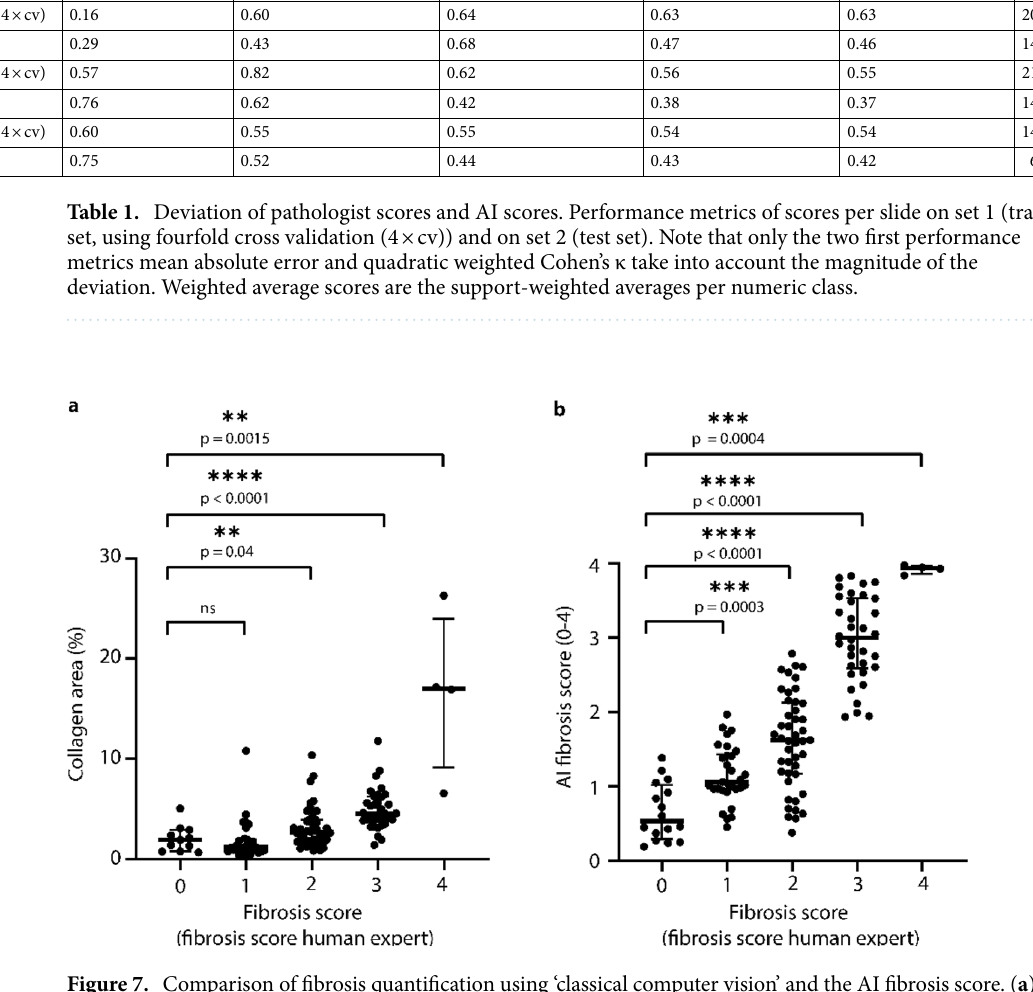
Figure 7. Comparison of fibrosis quantification using ‘classical computer vision’ and the AI fibrosis score. ( a ) Analysis with ‘classical computer vision’. The collagen area (%) obtained from analyzing the collagen specific color component of Masson’s Goldner stain shown on the vertical axis compared to the pathologist’s fibrosis scores. For the more severe fibrosis scores 2, 3 and particularly 4 collagen area is significantly elevated compared to the control (fibrosis score 0). The initial changes (fibrosis scores 1 and 2) result in a no or a moderate increase in collagen area. ( b ) With the AI fibrosis score, all levels of fibrosis can be discriminated significantly from the control (score 0). The difference in resolution can be explained by the different working mechanisms. The AI-based detection can be trained to recognize differences in morphological structures before they markedly impact area (%), e.g., sinusoidal collagen. AI scores are from validation data of 4 × cross